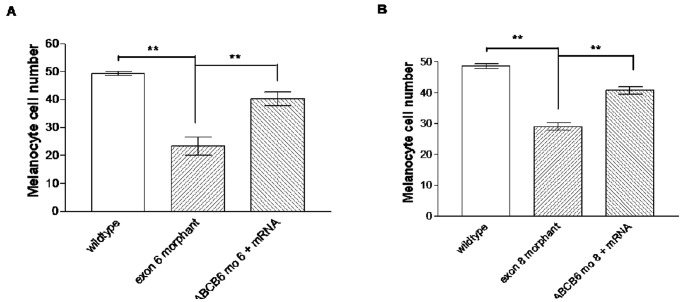
Number of melanocytes in the defined head regions in uninjected control (wildtype), exon 6- and exon 8-morphants and rescued embryos.**P<0.001 (ANOVA one-way analysis of variance with Tukey’s multiple comparison post test).